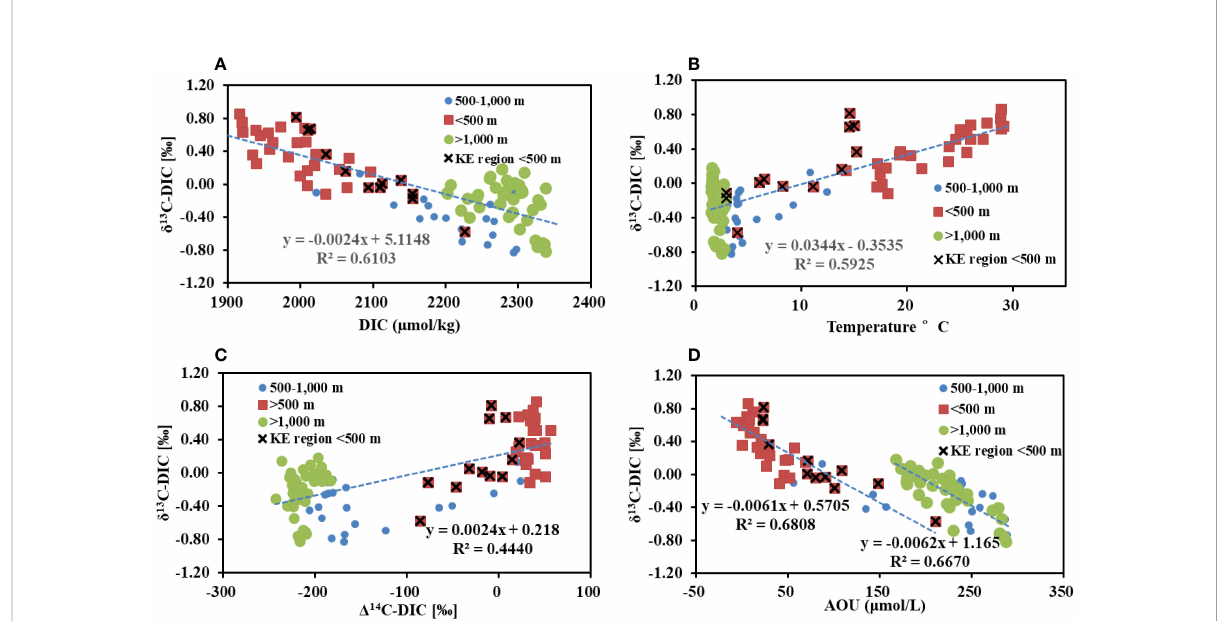
FIGURE 4 Plots of concentrations of d 13 C-DIC versus (A) DIC, (B) water temperature, (C) D 14 C and (D) apparent oxygen utilization (AOU) for water samples along transect P1 in the western NP. The AOU data is cited and replotted from Ge et al. (2022b) for comparison discussion. The lines are linear regressions that fi t the